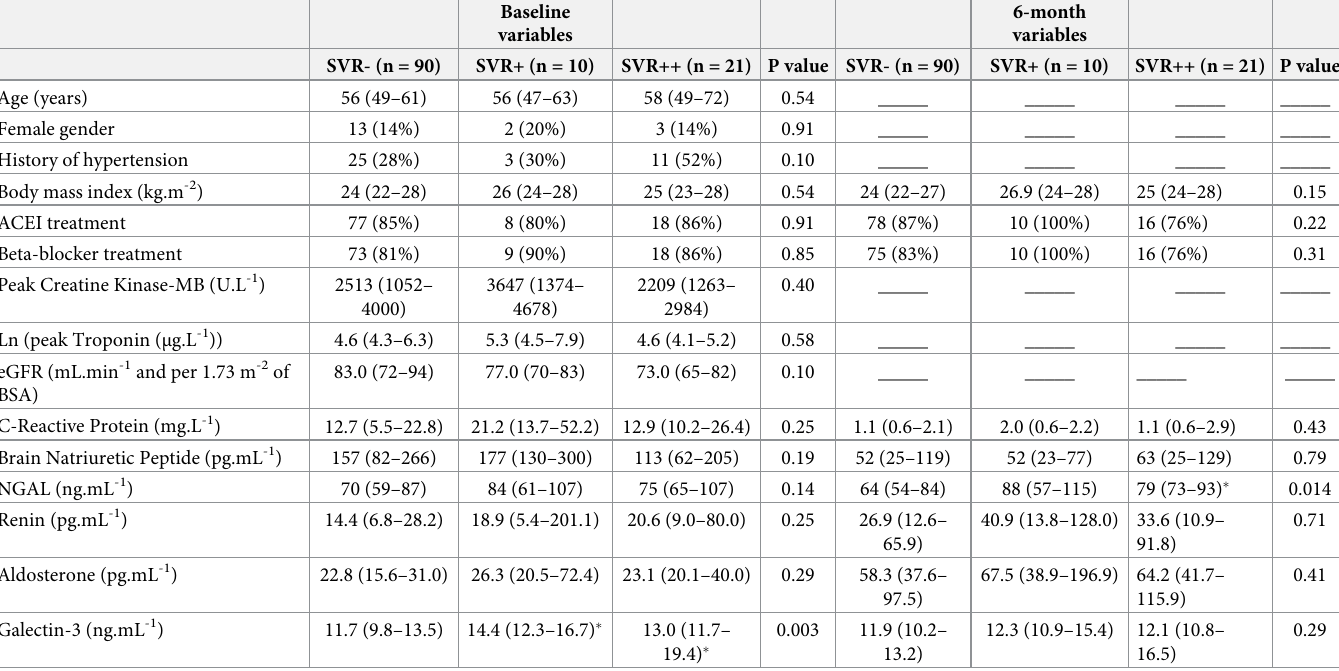
Table 1. Comparisons of clinical variables and blood biomarkers between patients with normal SVR at 6 months (SVR-), those with abnormal SVR only at 6 months (SVR+) and those with abnormal SVR both at baseline and 6 months (SVR++). Baseline variables